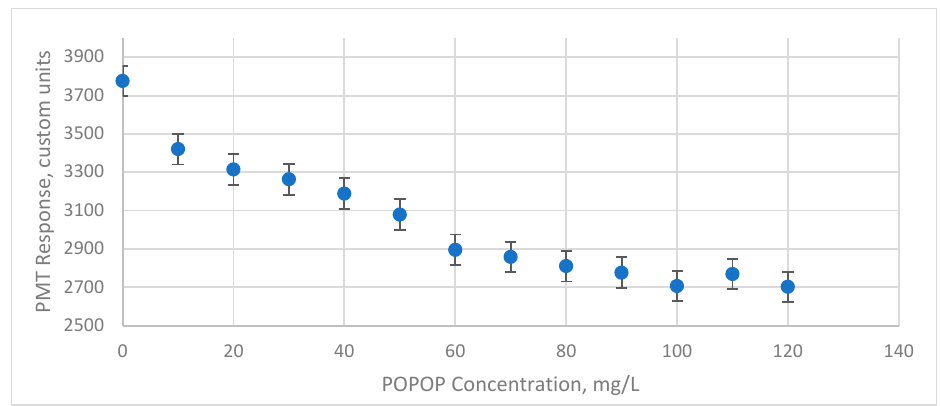
Figure 6. R580 PMT response for different POPOP concentrations in a 10 g/L PPO scintillator.